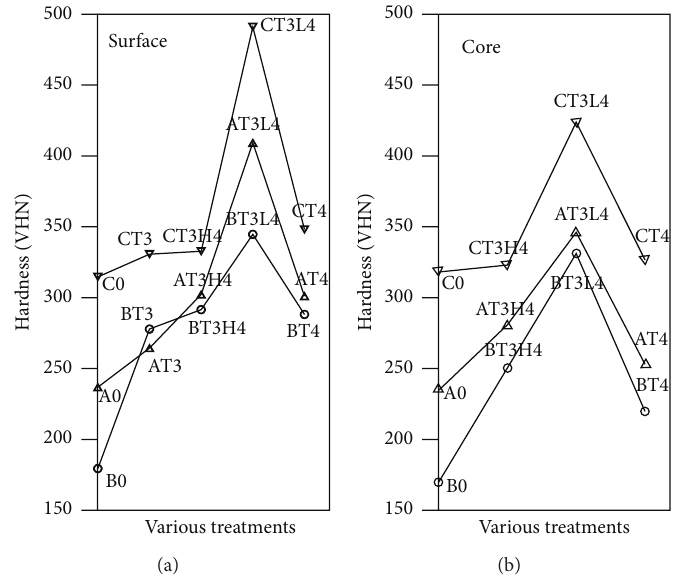
Figure 11: Variations of VHN for different treatments at (a) surface and (b) core.